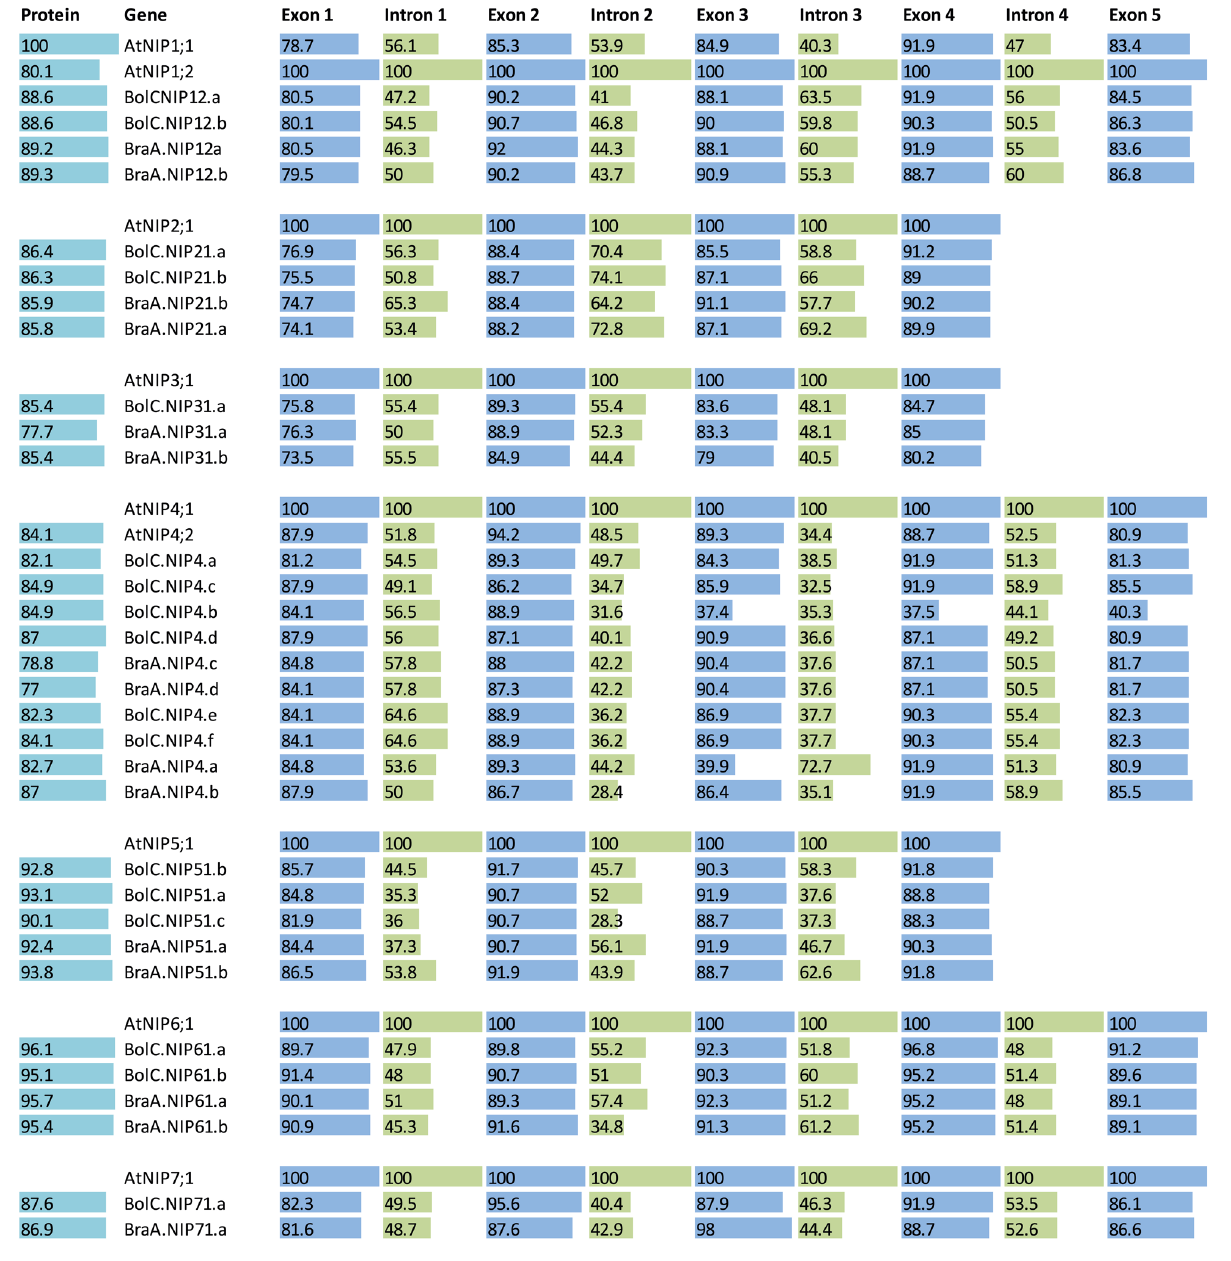
isoforms were normalized to this. If two At isoforms exist then the most similar isoform (compared with the other genes) was chosen as a standard and set to 100%. Exon and intron identities are displayed in blue and green, respectively and protein identities are displayed in light